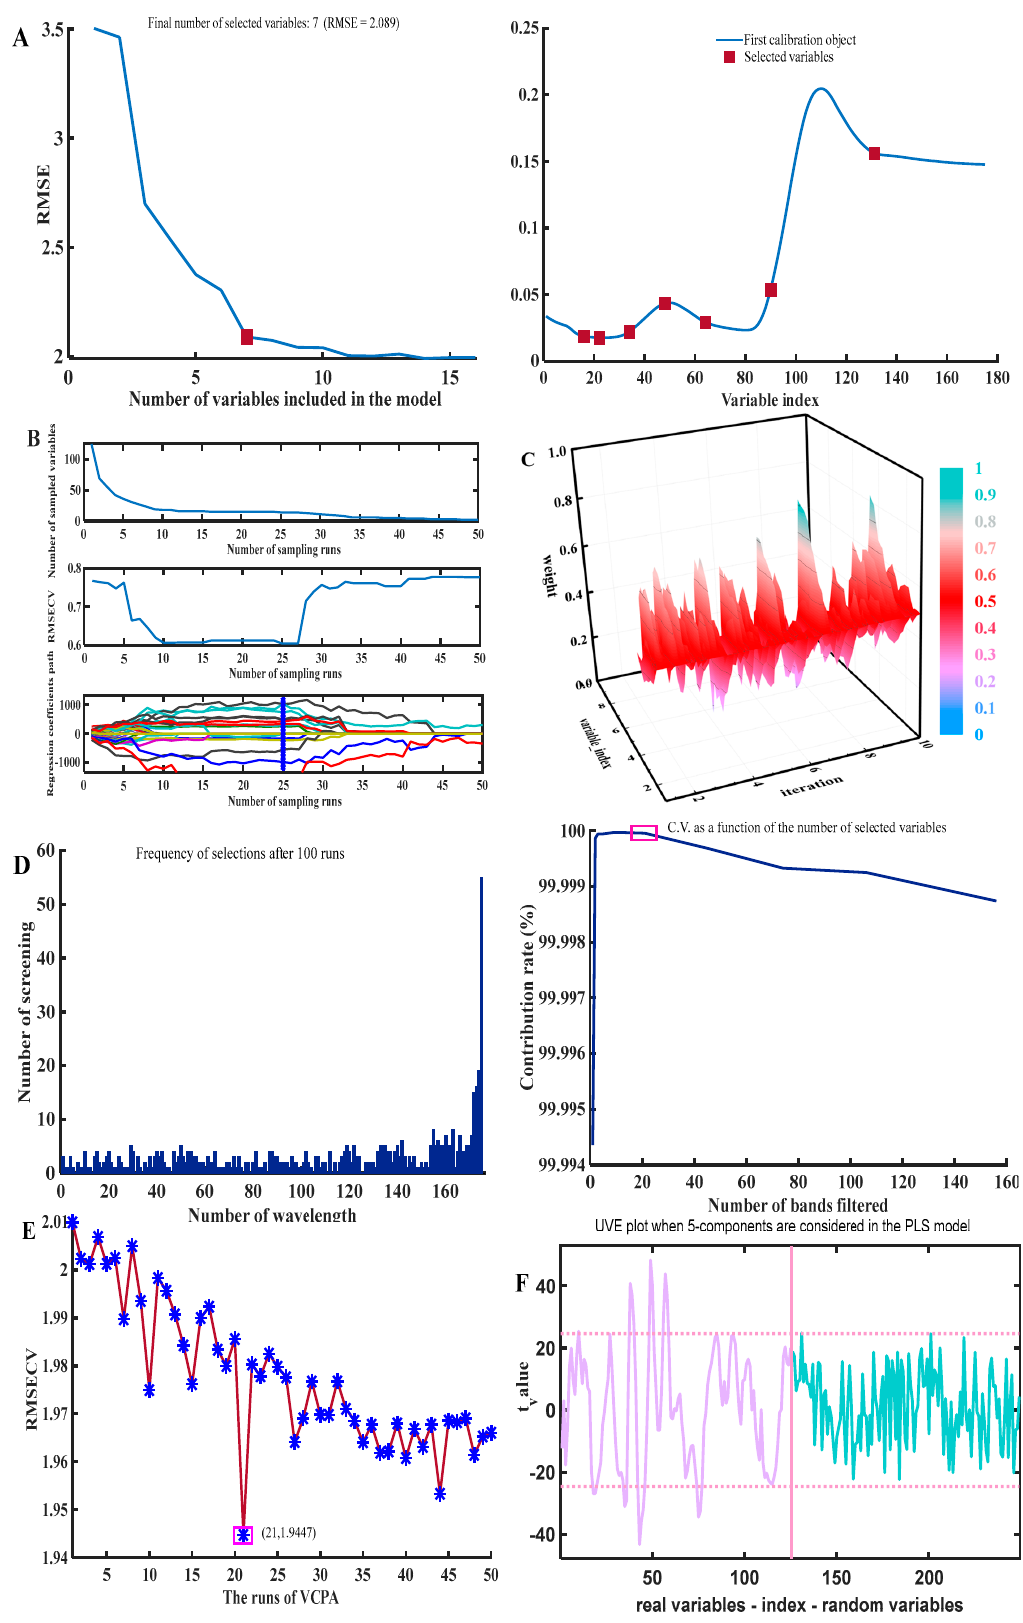
Figure 6. The running process of the selection of feature wavelengths: ( A ) is SPA; ( B ) is CARS; ( C ) is iVISSA; ( D ) is GAPLS; ( E ) is VCPA; ( F ) is